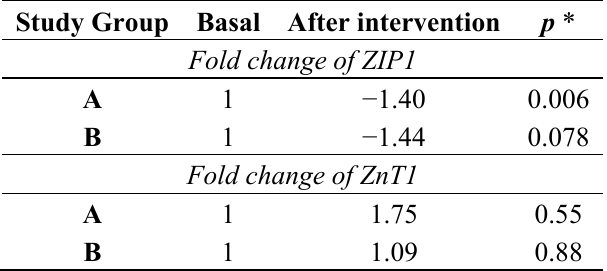
Table 4. Expression of zinc importer (ZIP1) and zinc exporter (ZnT1) in blood leukocytes from adolescent girls from groups A and B, at basal and after 27 day intervention. Study Group Basal After intervention p